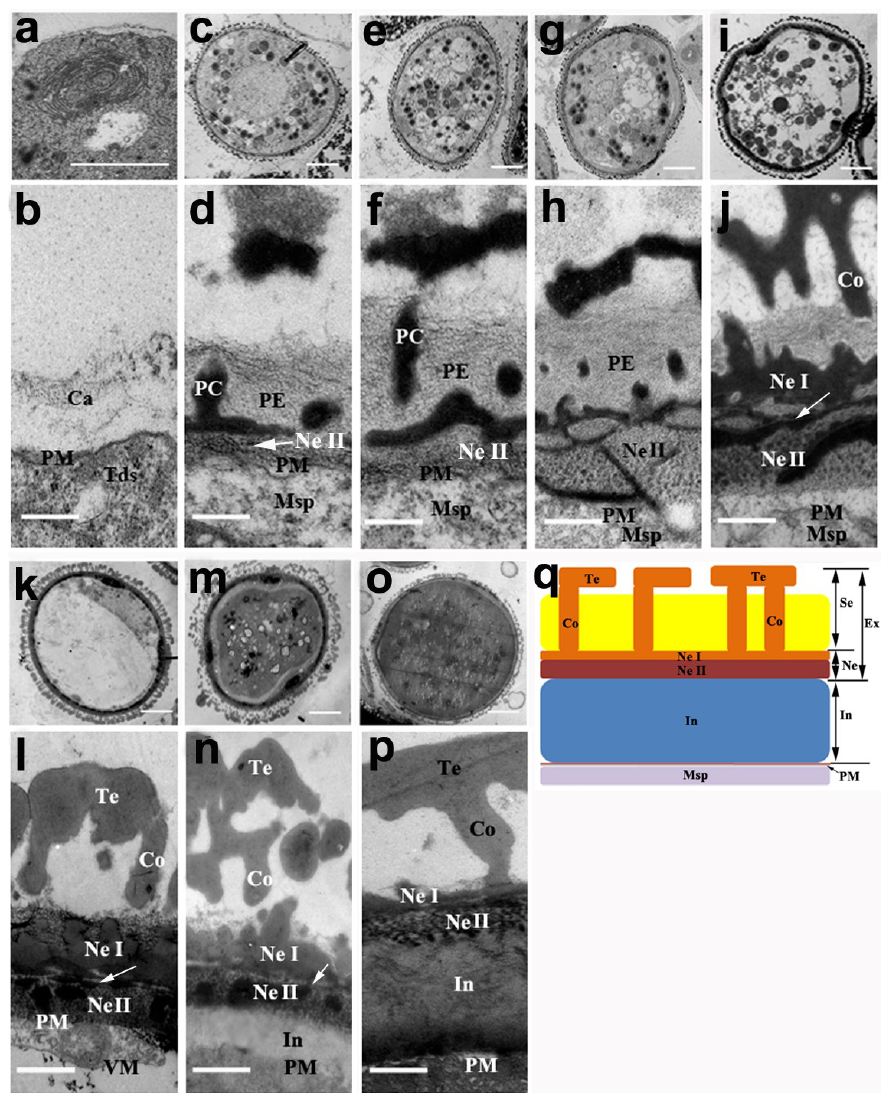
Figure 5. The development of the pollen wall in the transmission electron microscopy ( a – p ) of N. nucifera ‘Honghu Hong’. ( a ) Microspore at the tetrad stage. ( b ) The callose wall was the first of several layers deposited on the microspore surface at the tetrad stage. ( c ) Microspore at the early young microspore stage. ( d ) Detail of the microspore wall at the early young microspore stage, the arrow indicates the nexine II. ( e ) Microspore at the early young microspore stage, slightly later than Figure 5d. ( f ) Detail of the microspore wall at the early young microspore stage, slightly later than Figure 5d. ( g ) Microspore at the middle young microspore stage. ( h ) Enlargement of the microspore wall at the middle young microspore stage. ( i ) Microspore at the late young microspore stage. ( j ) Detail of the microspore wall at the late young microspore stage. ( k ) Microspore at the early bicellular pollen stage. ( l ) Detail of the microspore wall at the early bicellular pollen stage. ( m ) Microspore at the late bicellular pollen stage. ( n ) Detail of the pollen wall at the late bicellular pollen stage. ( o ) Microspore at the mature pollen stage. ( p ) Detail of the pollen wall at the mature pollen stage. ( q ) Proposed model of the pollen exine structure. The white arrow indicates the formation of white-line-center between nexine I and nexine II in (j, l, n) . Ca, callose; Co, columella; In, intine; Msp, microspore; Ne, nexine; Ne I, nexine I; Ne II, nexine II; PC, precolumella; PE, primexine; PM, plasma membrane; PN, prenexine; Se, sexine; Tds, tetrads; Te, tectum; VM, vacuole membrane. ( a , c , e , g , I , k , m , o ) Bar = 5 μm; ( b , d , f , h , j ) Bar = 0.5 μm; ( l , n , p ) Bar = 1.0 μm.